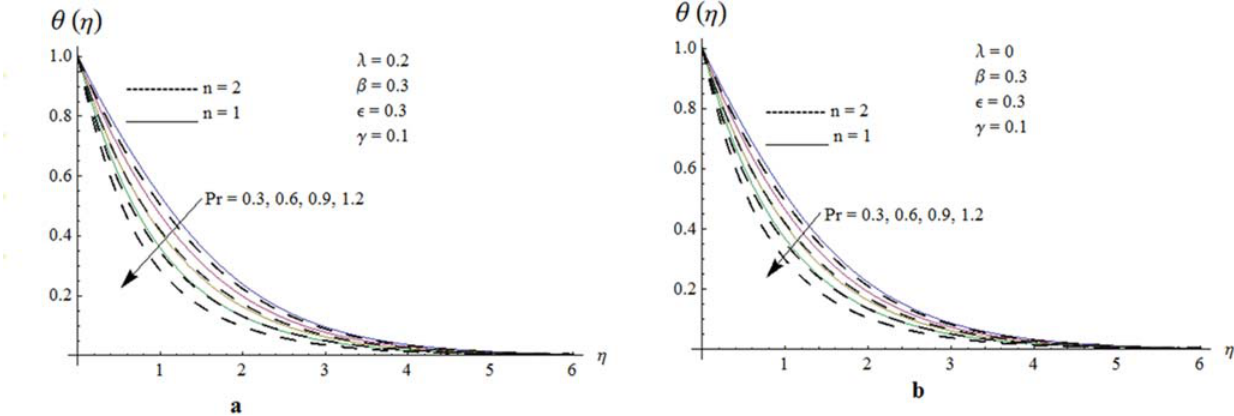
Fig 10. Effect of Pr on temperature profile when λ = 0.2 and λ = 0.